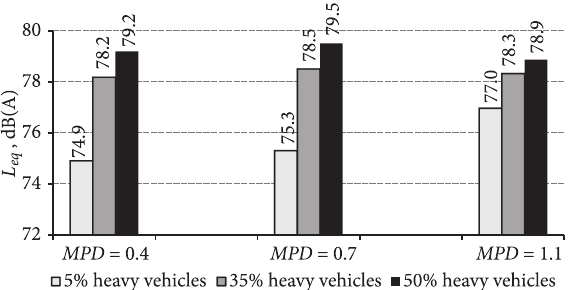
Fig. 9. Equivalent noise level at a distance of 7.50 m for different macrotexture of pavements and different traffic flow